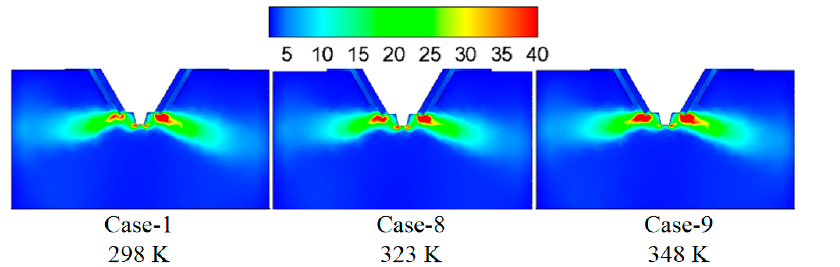
Figure 12. Effect of wastewater flow rate on evaporation performance.